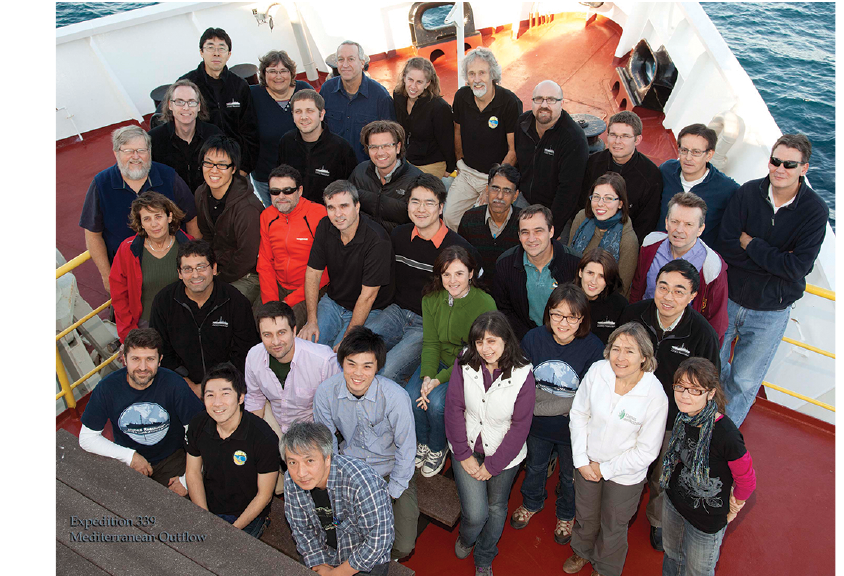
Figure 6. IODP Expedition 339 Scientists (Credit: John Beck, IODP /